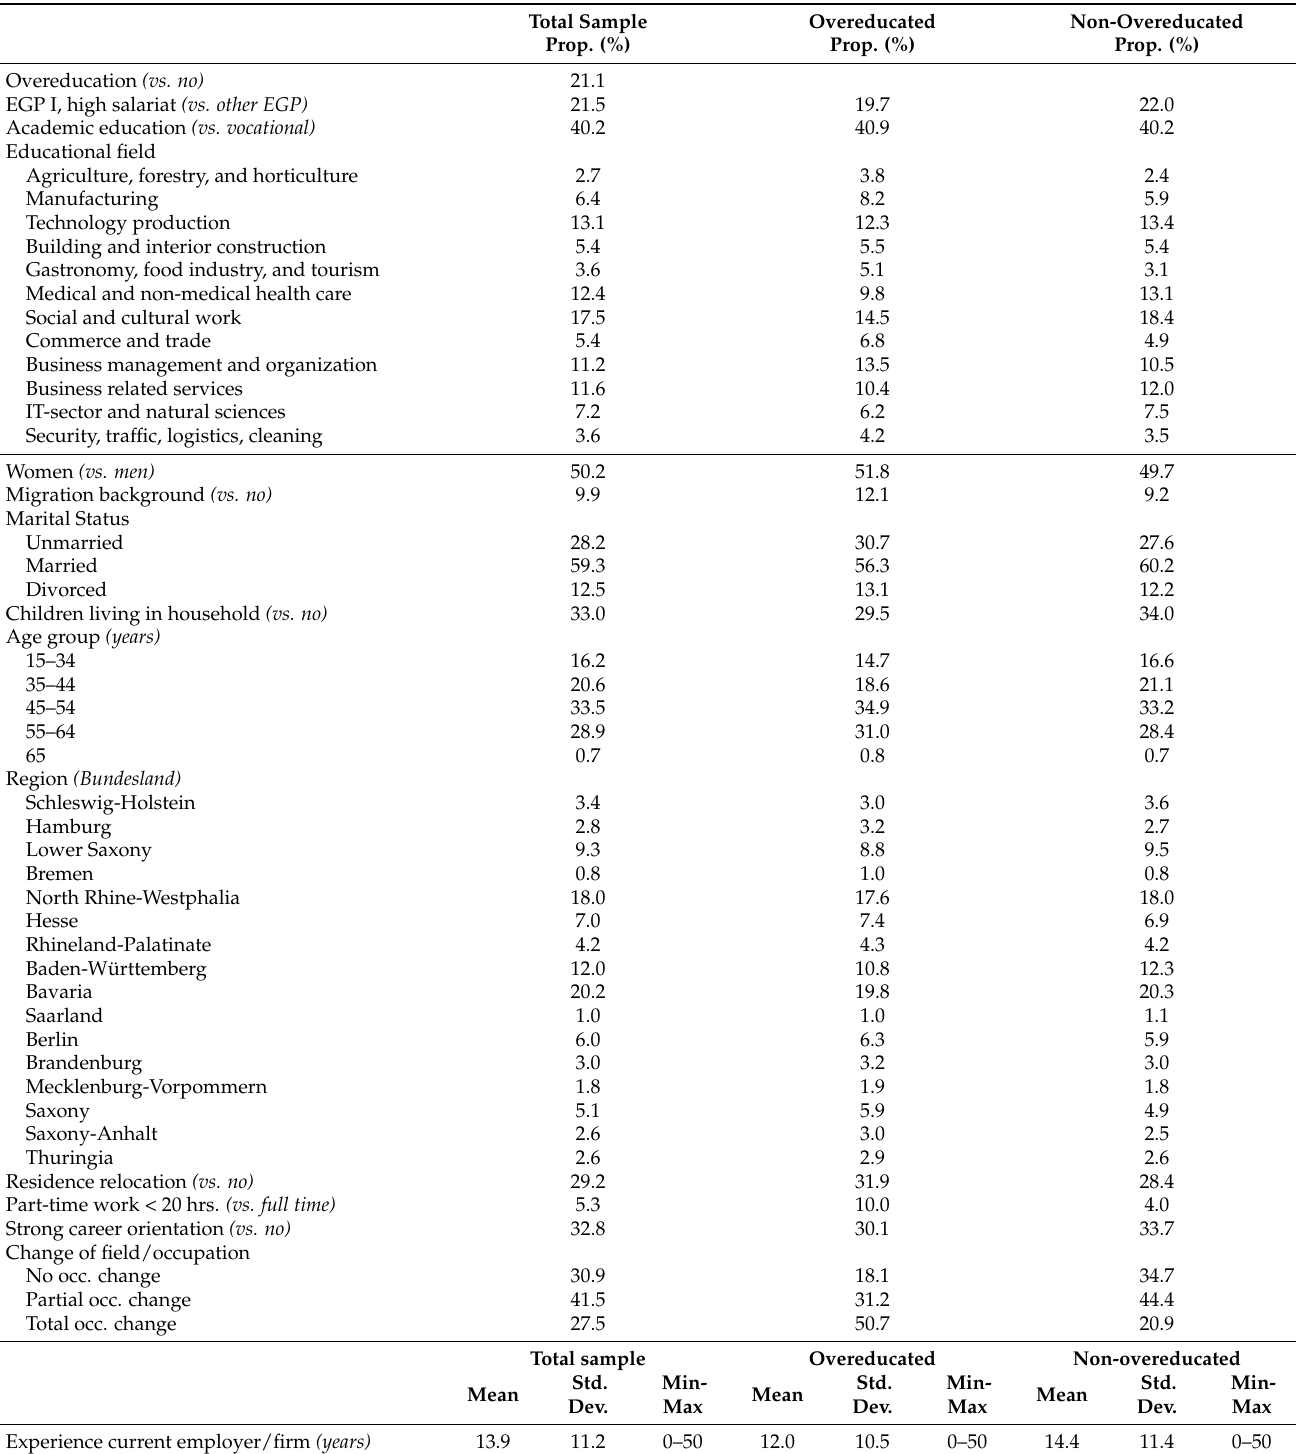
Table 1. Description of variables for all workers, as well as for overeducated and non-overeducated workers ( N = 15,605). Unweighted proportions. Data: BIBB/BAuA Employment Survey 2018, authors’ own calculations. Total Sample Overeducated Non-Overeducated Prop. (%) Prop. (%) Prop. (%) Overeducation (vs.